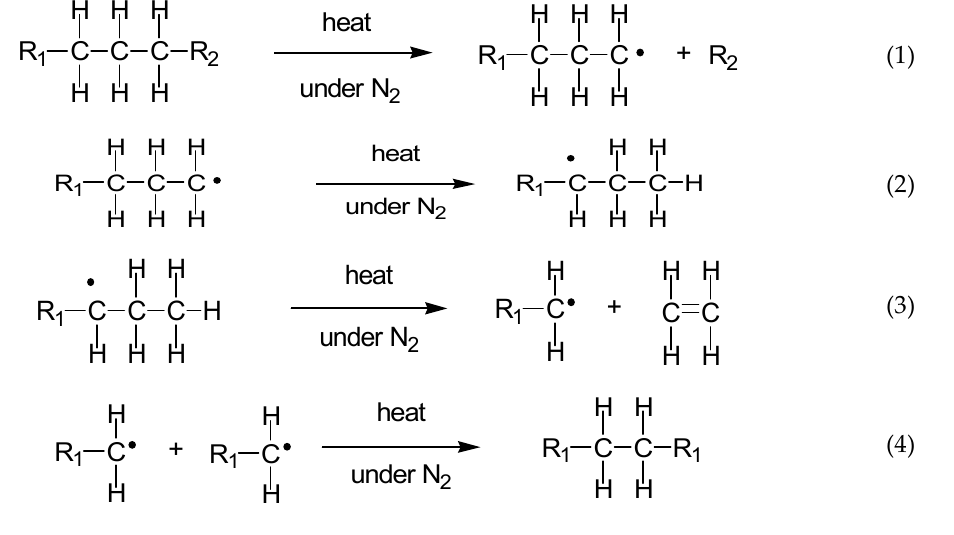
Table 5. Pyrolysis products yields for different used lubricant oil and plastic wastes (Lab-scale). Products Yield (%wt.)